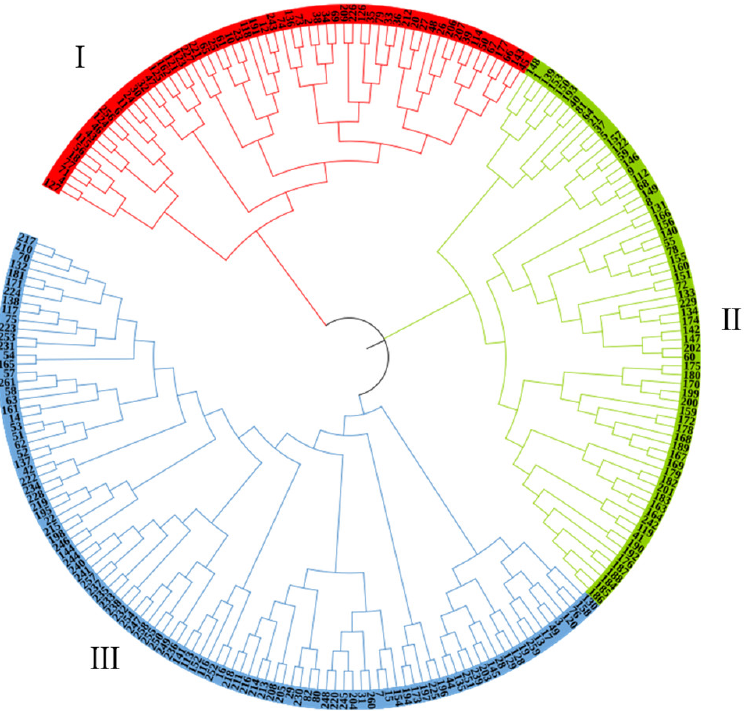
Figure 5. Phylogenetic tree of all 232 C. hystrix elite germplasms based on the SSRs built by the neighbor-joining method in PowerMarker 3.25 software. I, II and III represent the three categories of clustering, respectively.